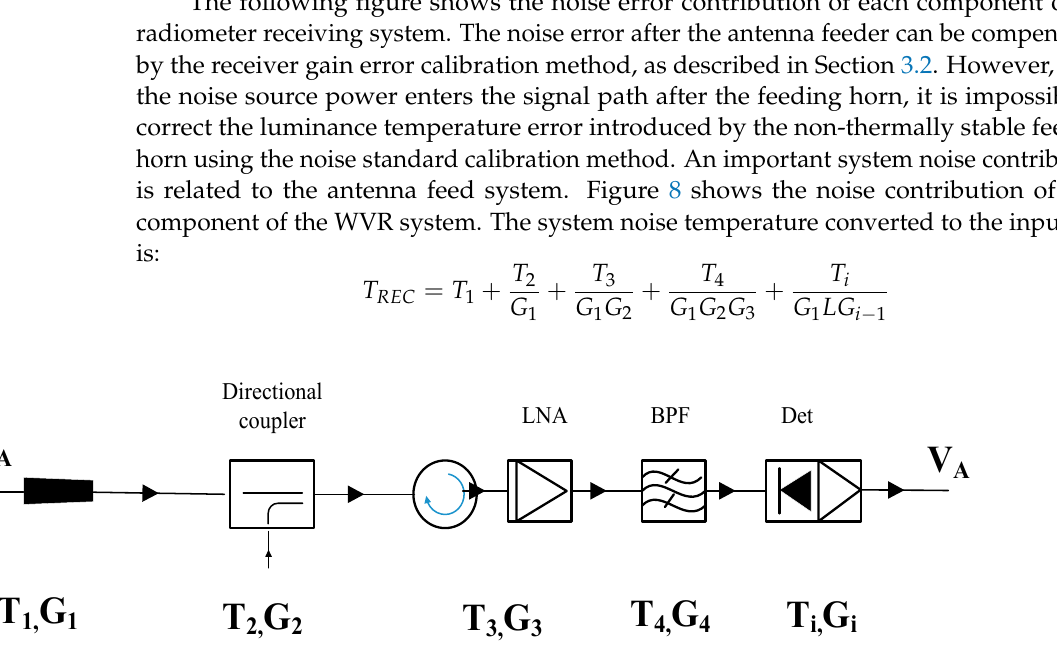
typical loss of a waveform feedforward horn running at 20~30 GHz is less than L = 1 dB. When the physical temperature of the feedforward horn changes by 10 ◦ C, the system